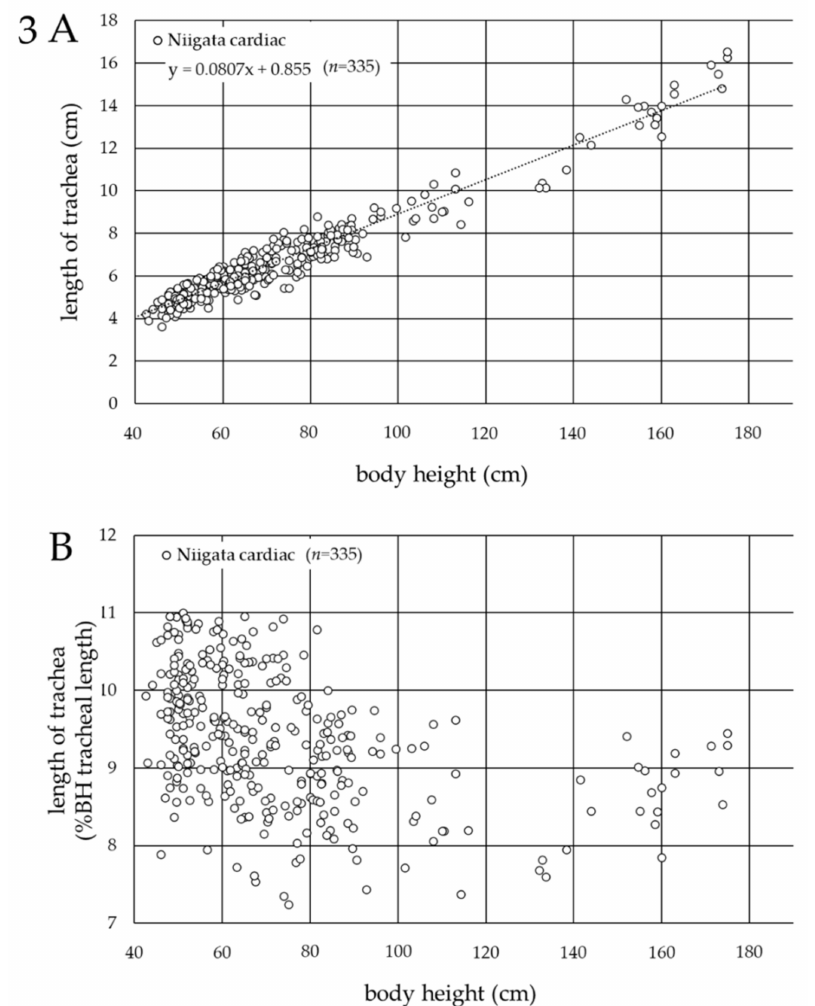
Figure 3. Association between the tracheal length and body height in cardiac pediatric patients in Japan. ( A ) Horizontal axis: body height (cm); vertical axis: tracheal length (cm). The average tracheal length (cm) = 0.0807 × (body height (cm)) + 0.855 (R 2 = 0.942). ( B ) Horizontal axis: patients’ body height (cm); vertical axis: % ratio of the tracheal length to body height (%BH tracheal length)